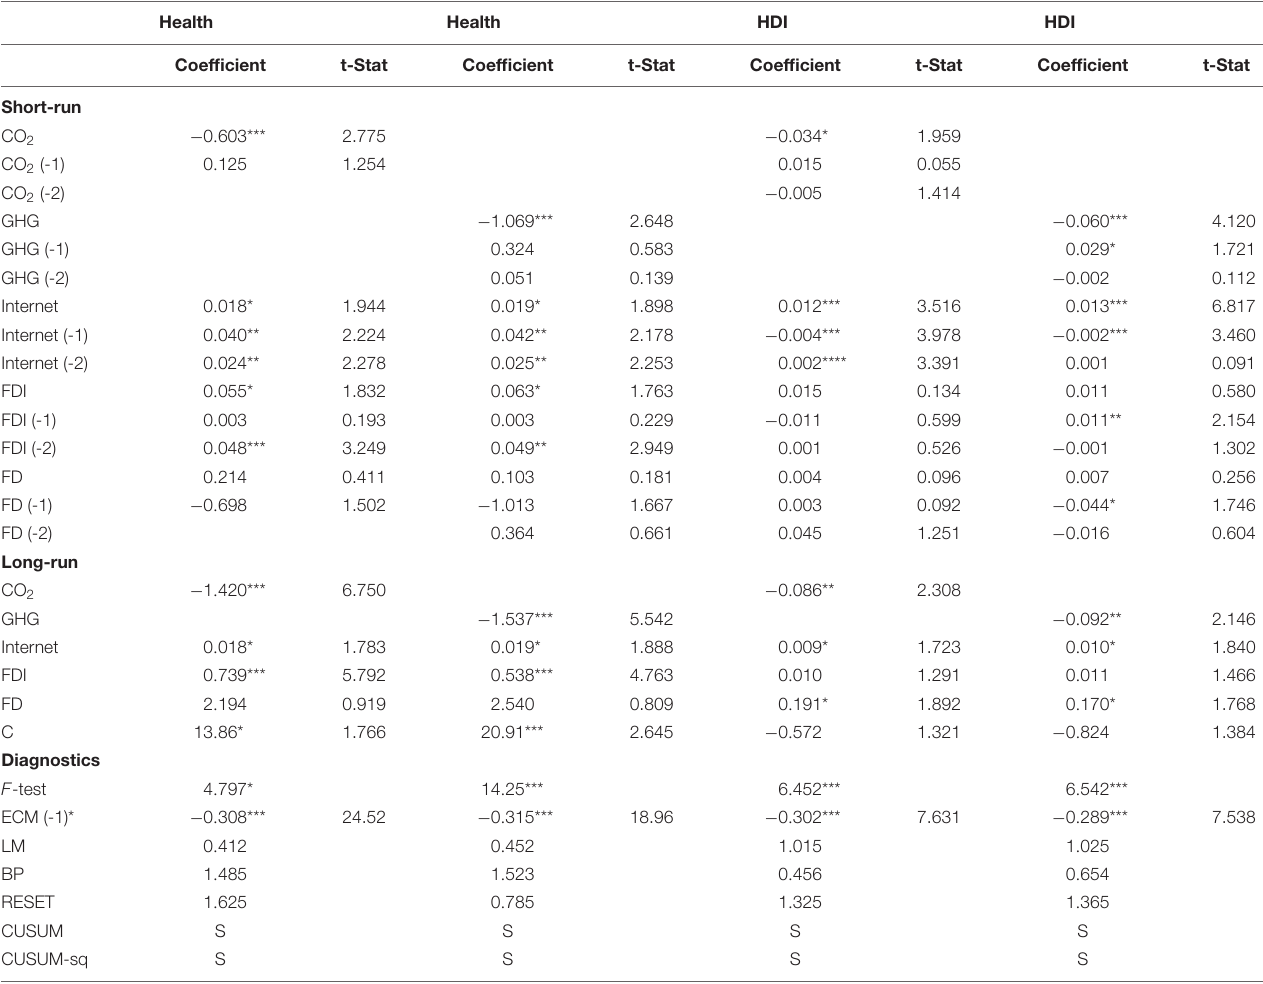
TABLE 3 | ARDL estimates of health and human